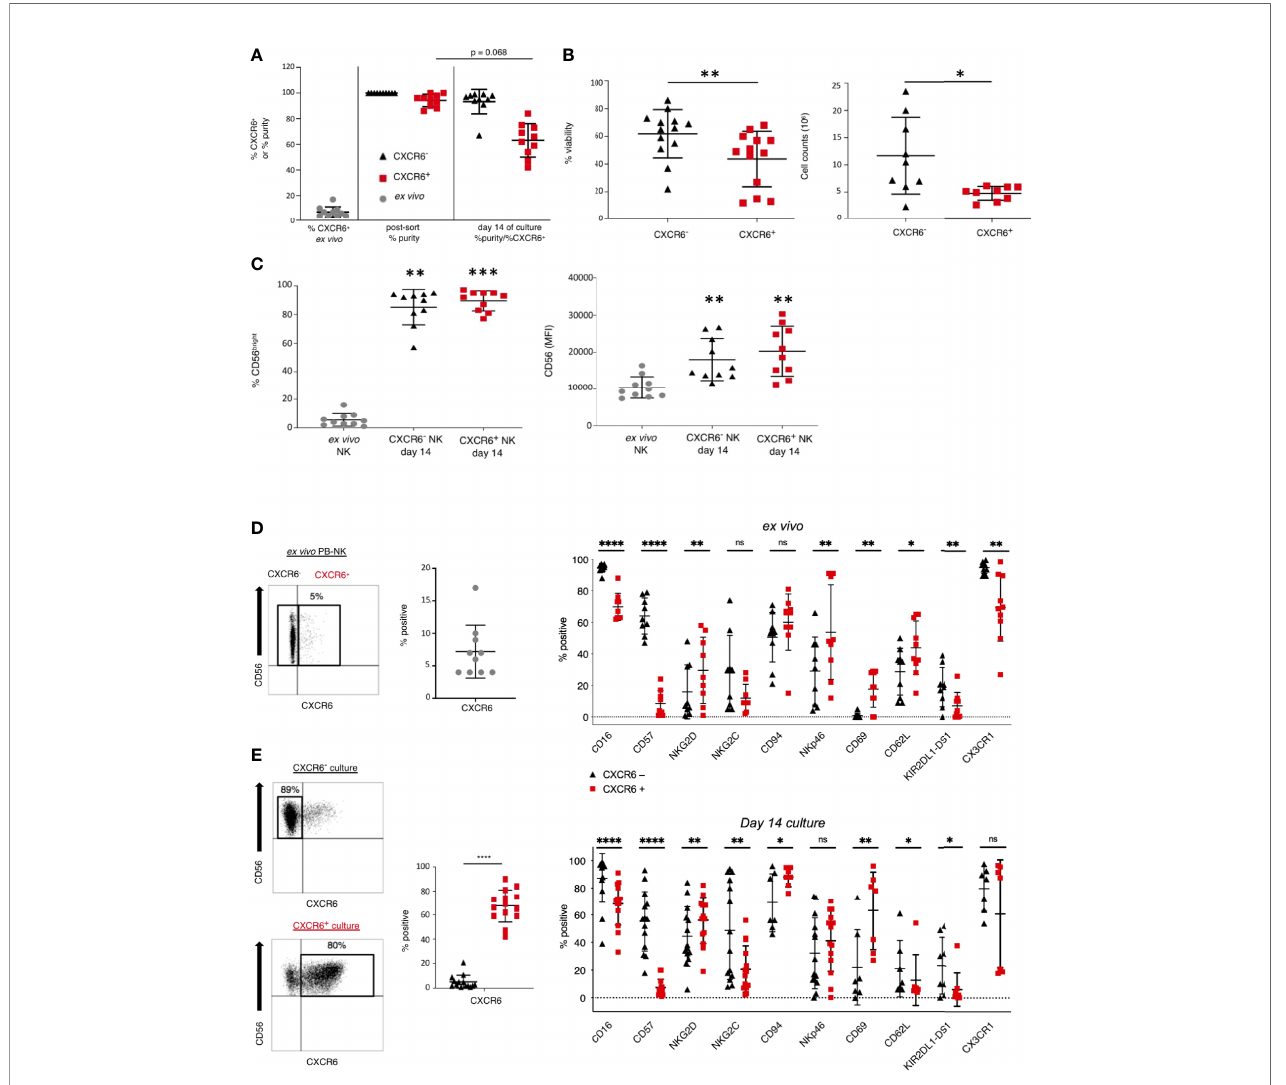
FIGURE 1 | CXCR6- and + NK cell cultures differ in purity, viability, and expansion capacity after in vitro expansion. (A) Percent CXCR6 + NK cells in pre-sorted PB and purity of CXCR6 - and + NK cell cultures immediately post-sort and after a 14 day in vitro expansion. Pre-sorted ex vivo NK cells (gray circles), CXCR6 - NK (black triangles), and CXCR6 + NK (red squares). All values are mean +/ – standard deviation ( n=10) . (B) CXCR6 - NK cells are more viable and expand more readily than CXCR6 + NK cells at day 14 of culture ( n=13 ). Cells were counted using a hemocytometer and trypan blue exclusion ( n=9 ). (C) CD56 bright NK cells increase in CXCR6 - and + NK cell cultures by day 14. Percent CD56 + and CD56 MFI increases in both subsets compared to fresh donor-matched NK cells ( n=10 ). One-way ANOVA with Dunn ’ s multiple comparisons test (A, C) and Wilcoxon matched-pairs signed-rank test were performed (B) . (D) CXCR6- and + PB-NK cells have distinct phenotypic pro fi les ex vivo ( n=9-10 ), which are enhanced after in vitro expansion ( n=7 – 14 ) (E) . CXCR6 - NK cells within CXCR6 - 14-day cultures were gated, and CXCR6 + NK cells within CXCR6 + NK cell cultures were gated for analysis following immuno-staining and fl ow cytometry. Paired t-tests were performed for each marker. (*p < 0.05; **p < 0.01; ***p < 0.001; ****p < 0.0001; ns, not signi fi